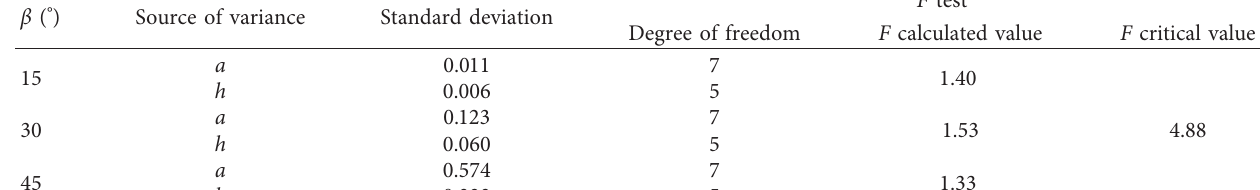
Table 6: The computational results of variance analysis and F test.